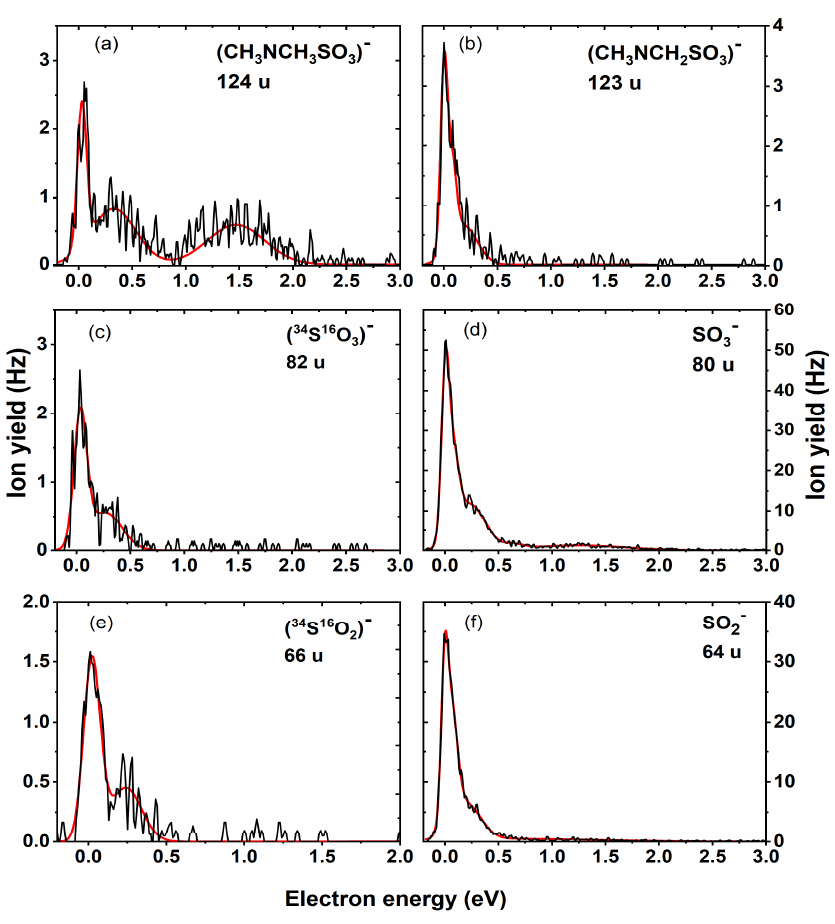
Figure 3. Anion efficiency curve for the fragment anions ( a ) CH 3 NCH 3 SO 3 − , ( b ) CH 3 NCH 2 NSO 3 − ( d ) SO 3 − , and ( f ) SO 2 − , and for the isotopes ( c ) 34 S 16 O 3 − and ( e ) 34 S 16 O 2 − formed upon DEA to DMSU.